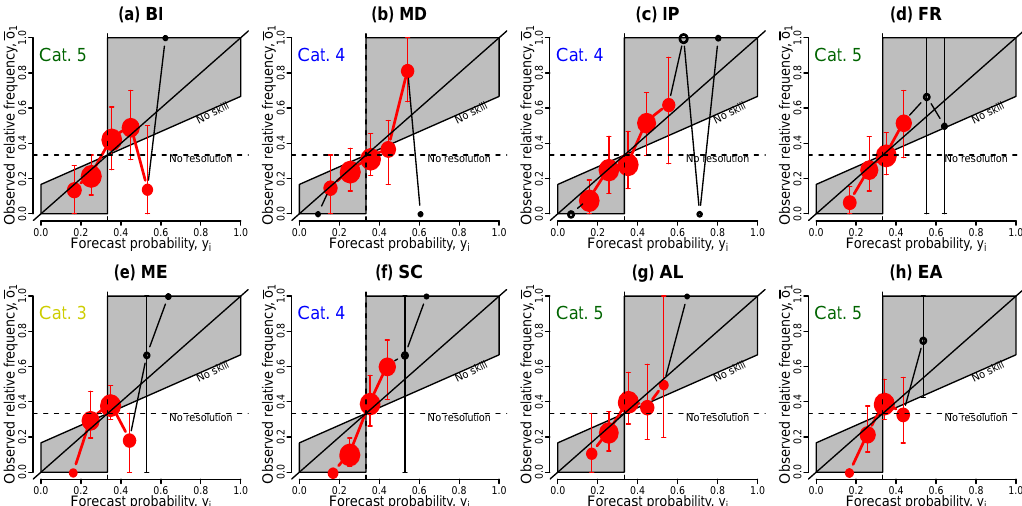
Figure 14. Reliability diagrams for low winter temperature, defined as seasonal DJF averages in the lower tercile. See the caption of Fig. 13 for technical